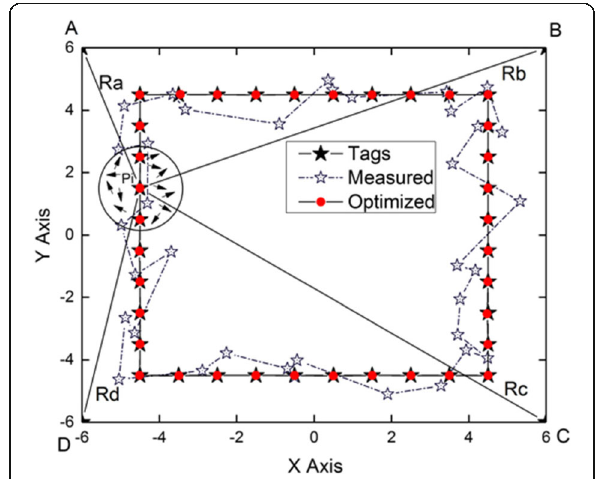
Fig. 9 2D indoor localization modeling and optimization. After the